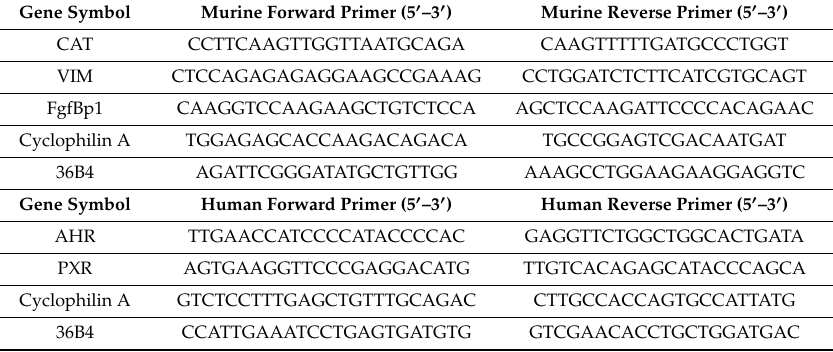
Table 1. Murine and human primers used in reverse transcription-coupled PCR (RT-qPCR) reactions. Gene